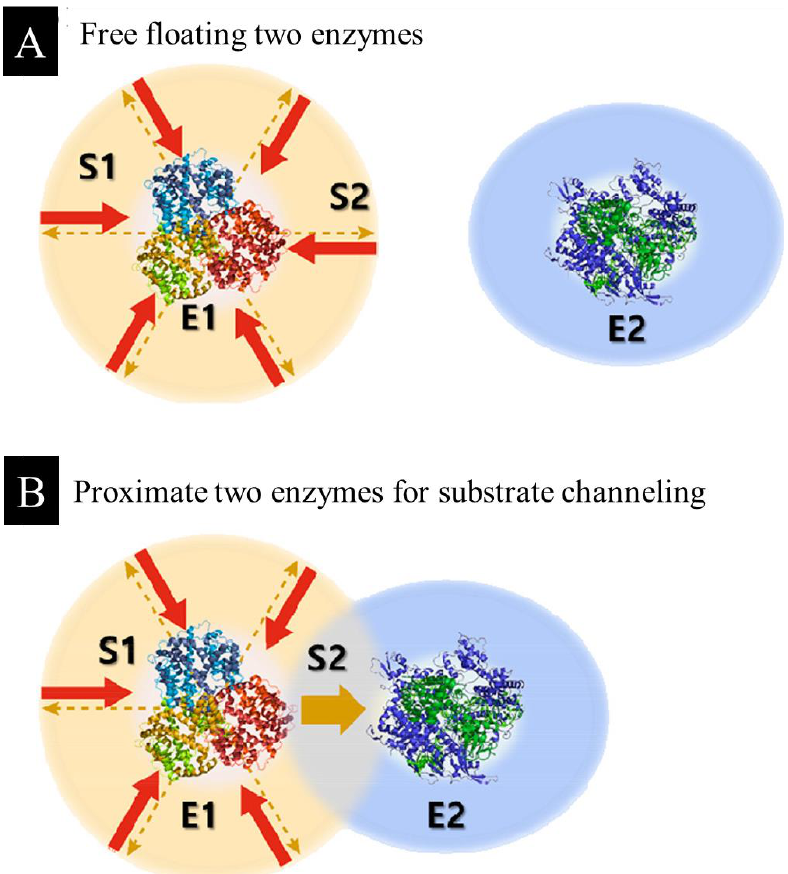
Figure 3. Schematic illustration of the substrate channeling effect between ( A ) two free-floating enzymes (E1 and E2) and ( B ) two proximate enzymes (E1/E2). Diffusion of the substrates (S1 and S2) and enzymes (E1 and E2) is assumed to be directional. Reproduced with permission from Hwang and Lee [71]. Copyright 2019 American Chemical Society.